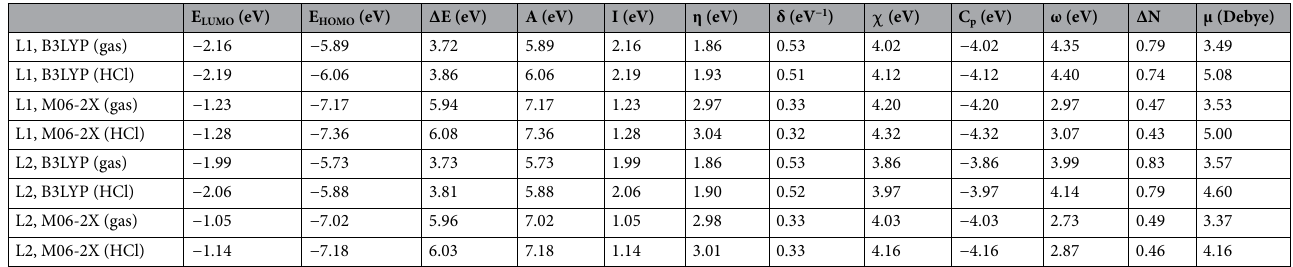
Table 4. Electronic parameters and reactivity